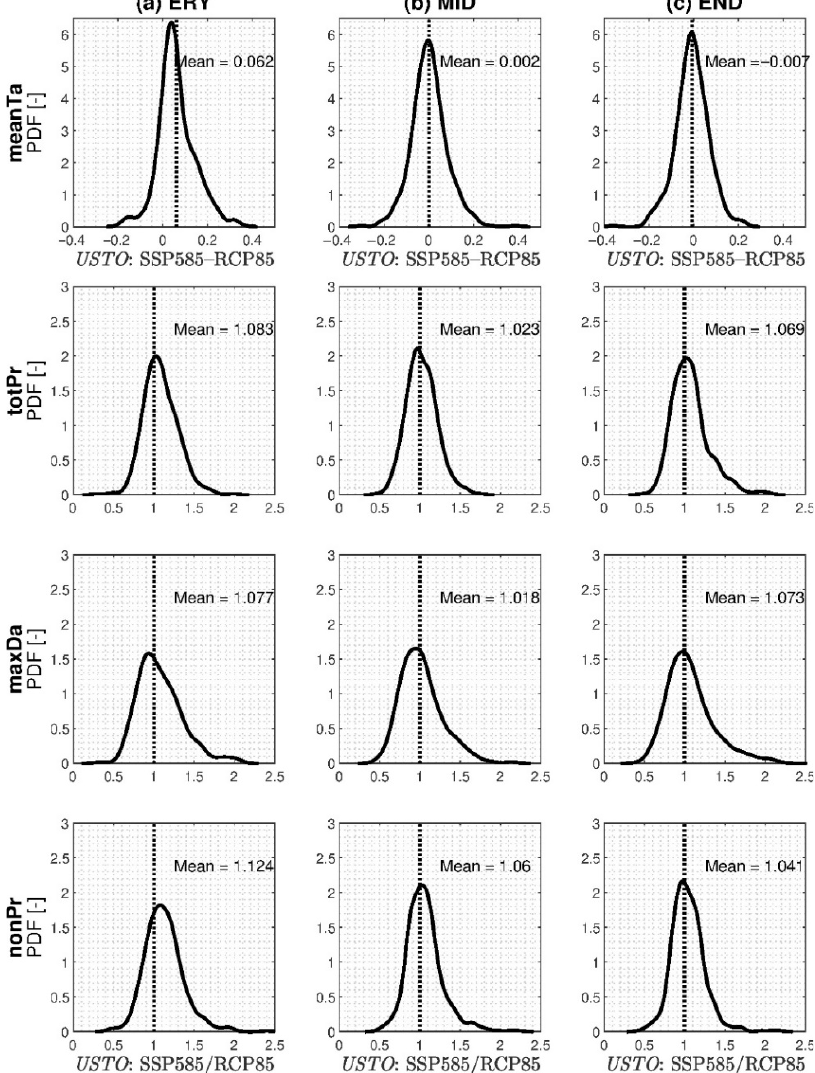
Figure 9. Non-parametric kernel distributions for the ratio of the USTO values between the emission scenario SSP5-8.5 of CMIP6 and RCP 8.5 of CMIP5: ( a ) ERY, ( b ) MID, and ( c ) END. Each row of plots corresponds to indices of meanTa, totPr, maxDa, and nonPr, respectively. The number of data points for establishing the distribution is 520 (40 locations × 13 (12 months + year)).